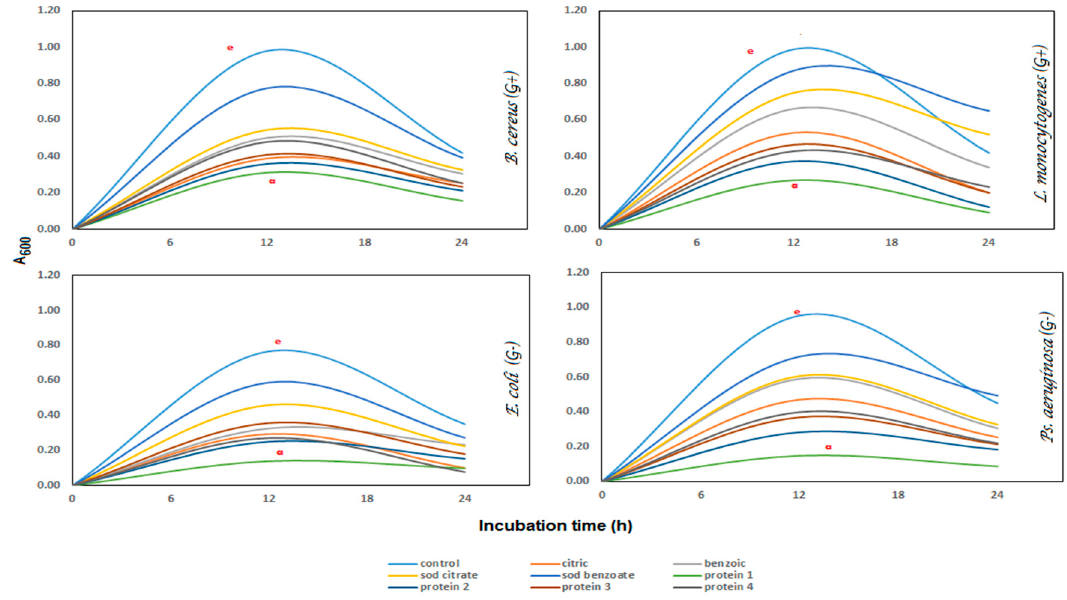
Figure 4. Growth curve of G + and G − bacteria in the presence of additives MIC levels.